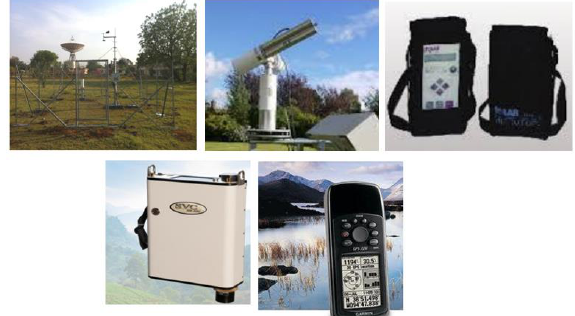
Figure 11. (Top row) AWS, Sun photometer, Ozonometer; (Bottom row): Spectro-radiometer and GPS.